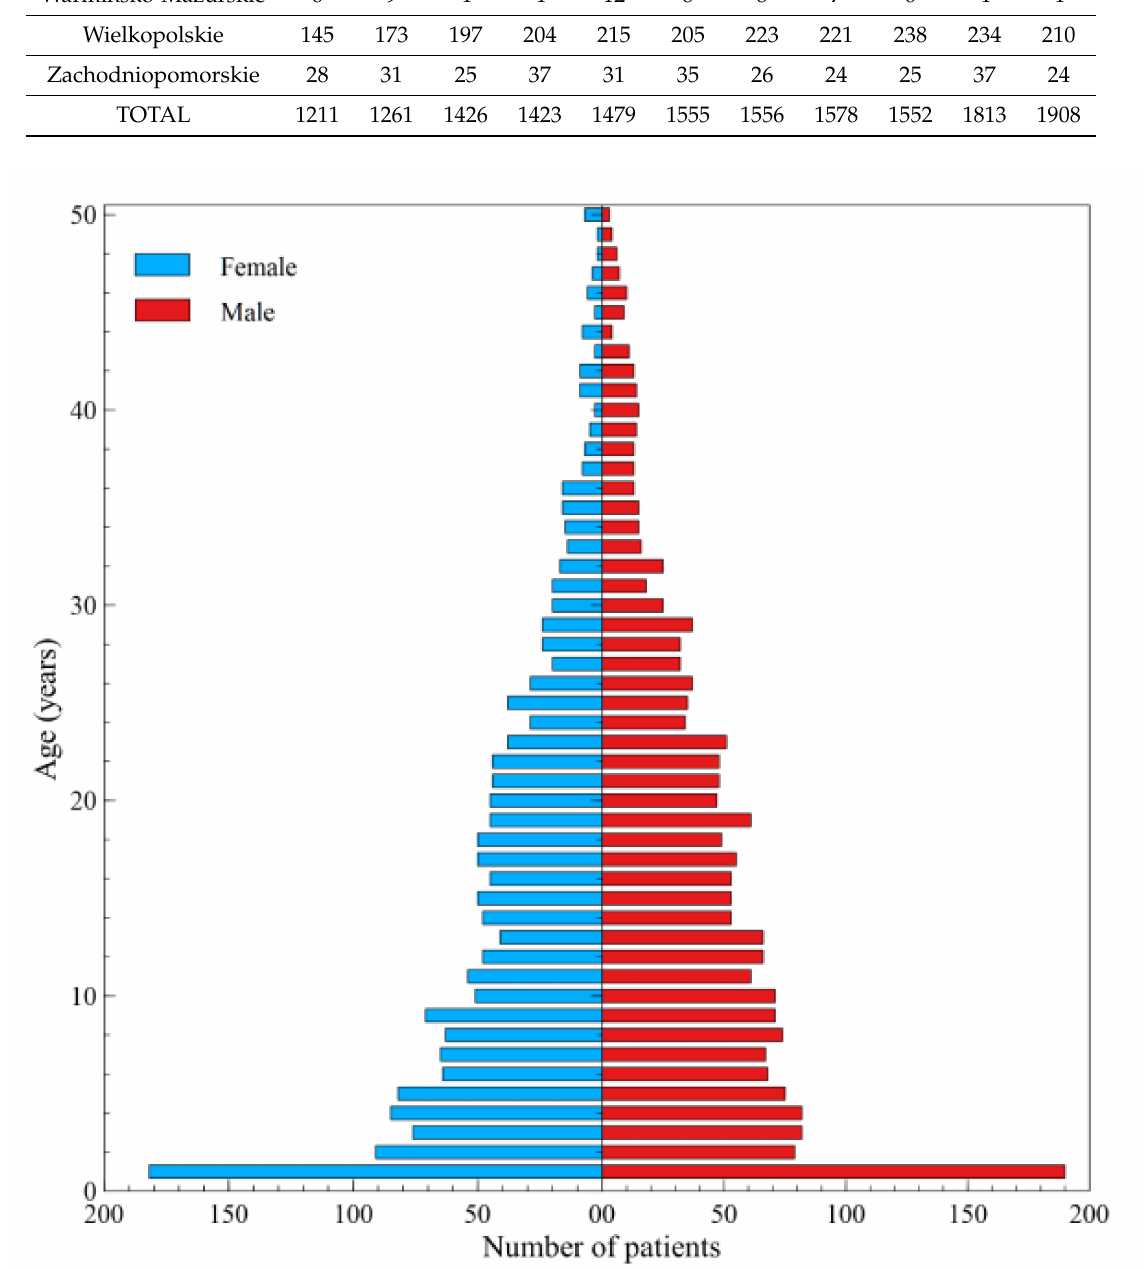
Figure 6. Distribution of services financed by NHF according to patients’ gender and age for all types of services and hospital care in